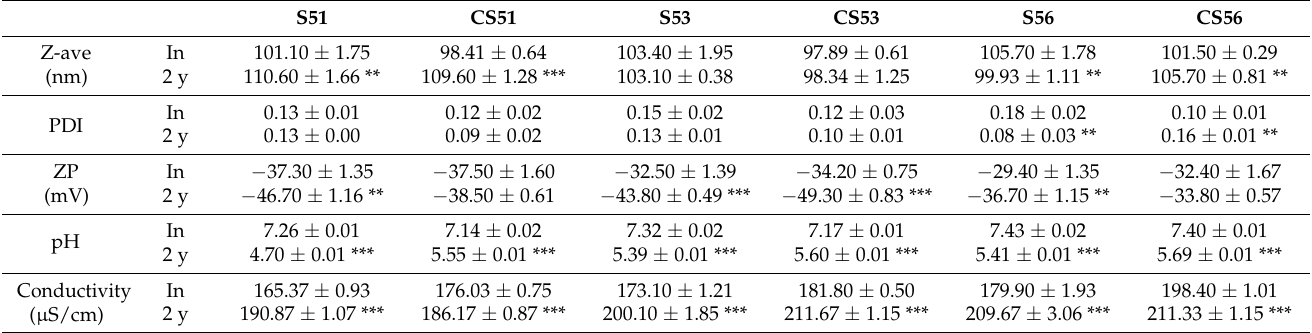
Table 7. Physicochemical parameters for soybean oil nanoemulsions containing PEG5000-DPPE measured initially (In) and after two years of storage at room temperature (2